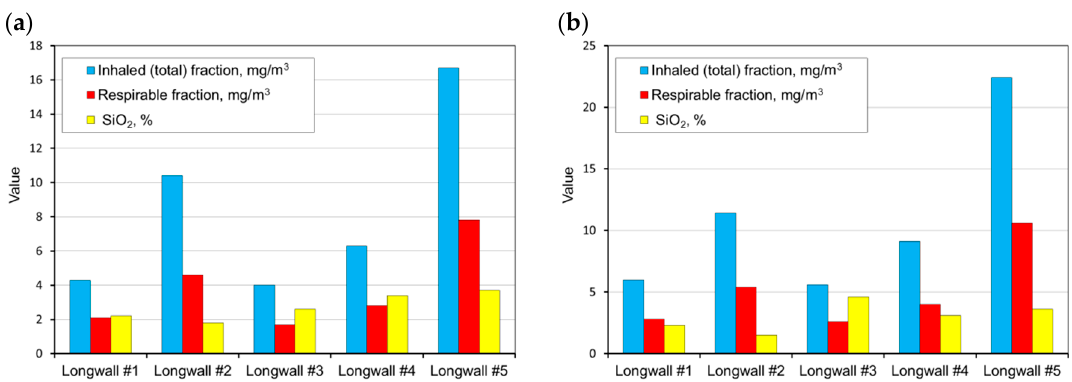
Figure 5. The measurement results for the dust levels in the positions of the miner working at the junction of the longwall with the maingate (air inlet) ( a ) and the shift foreman ( b ) (workplaces 6 and 10).